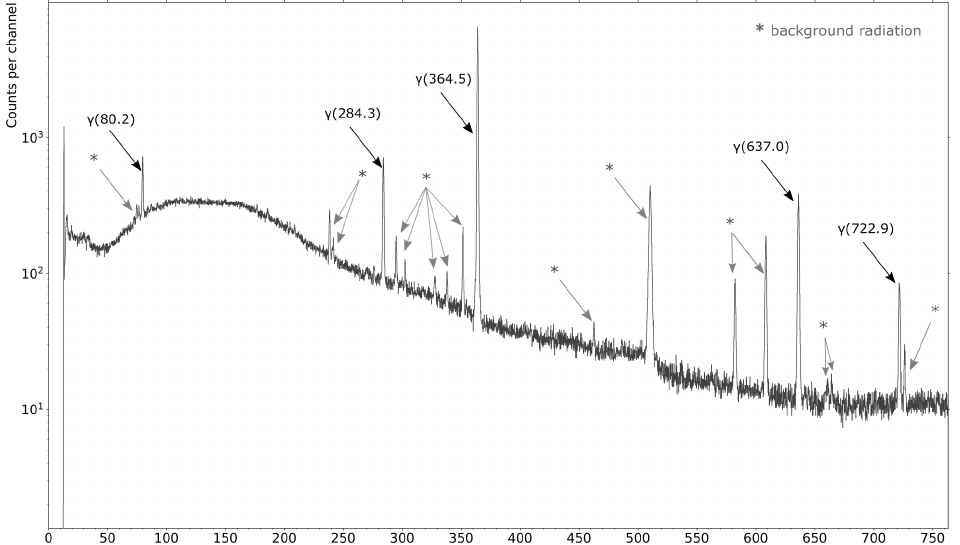
Figure 6. γ -ray spectroscopy of the 131 I powder after the transfer into the annealing vial, recorded in the ISOLDE experimental hall. The γ radiation characteristic of 131 I is labelled in black. These are lines at: 364.5 keV (81.5%), 637.0 keV (7.16%), 284.3 keV (6.12%), 80.2 keV (2.6%), and 722.9 keV (1.8%). The background γ radiation is marked with grey stars in the